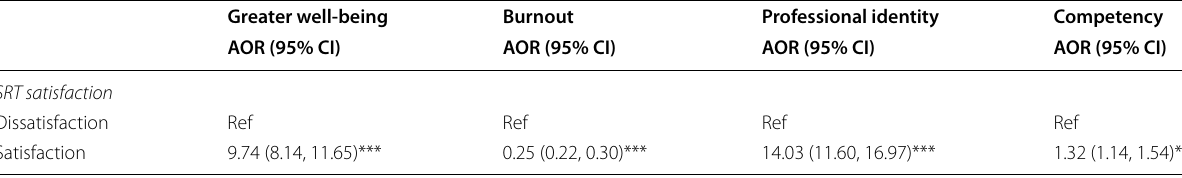
Burnout was measured by the Maslach Burnout Inventory-Human Service Survey (MBI-HSS), and participants with high EE ( defined as “having burnout.” Greater well-being is a dummy variable indicating respondents who felt overall satisfied with their psychological, emotional and physical. Professional identity is a dummy variable indicating respondents had higher professional identity level *** p < 0.001. All models were controlled for participants’ characteristics